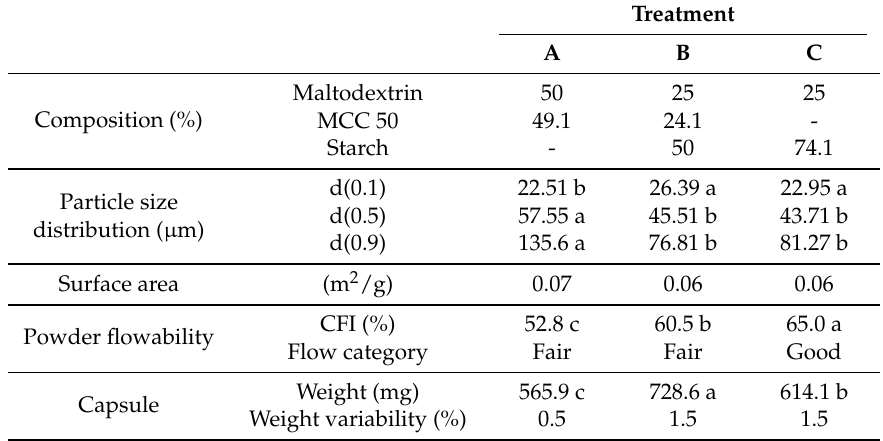
Table 4. Effect of the powder composition on its physical properties, flowability and capsule